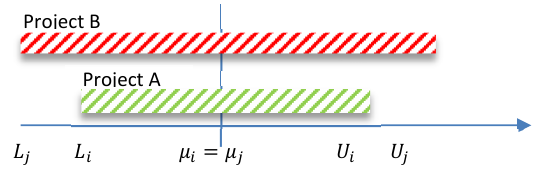
Fig. 7. Possible Condition 1- Similar Means and Different Domain Length